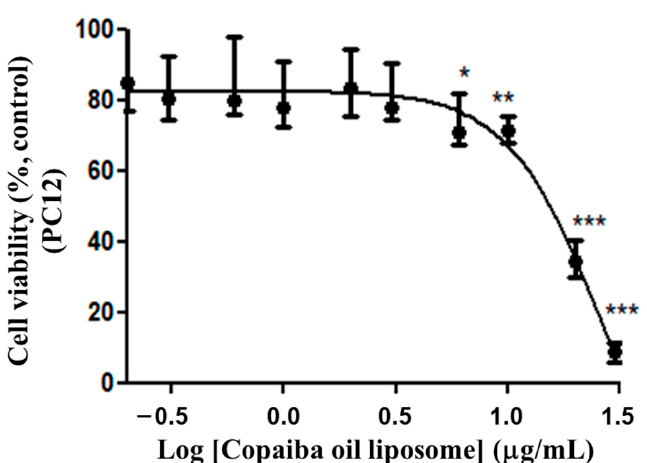
Figure 5. Dose–response curve of PC12 cells to CP-loaded conventional liposomes. Treatment at the dose of 0.2 to 30 μ g/mL of copaiba oil in conventional liposome for 72 h. The graph represents the experiment closest to the median of the EC 50 15.57 µ g/mL. Data are represented by a non-normal distribution in terms of the median and variation, analyzed by Kruskal–Wallis followed by Dunn’s comparison test. Statistical significance: (*) p < 0.01, (**) p < 0.001 and (***) p < 0.0001 compared to the control with 0.05% empty